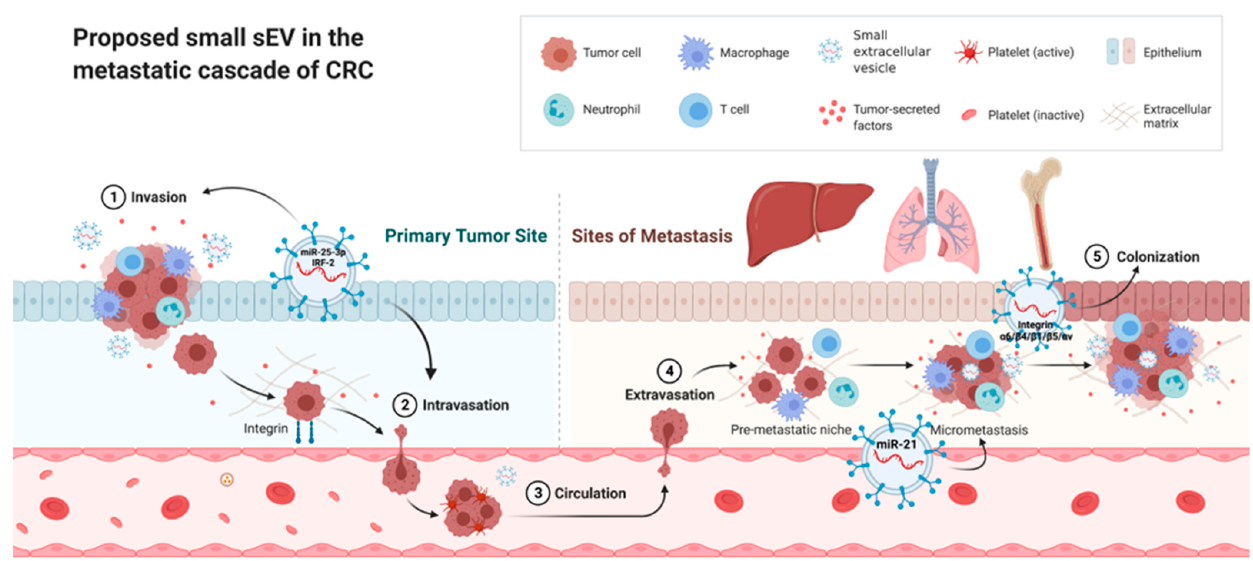
Figure 1. Proposed role of small EVs in the metastatic cascade of CRC Premetastatic niches (PMNs) possess six characteristics: vascular leakiness and angiogenesis, lymphangiogenesis, inflammation, immunosuppression, genetic reprogramming, and organotropism. sEVs play a vital role in each part of the above characteristics. CRC-derived sEVs containing miR-25-3p contribute to the induction of vascular leakiness and angiogenesis. Furthermore, sEVs containing miR-25-3p may impair the junctions of the endothelial cell layer. CRC-derived sEVs containing IRF-2 have been postulated to stimulate VEGF-C (vascular endothelial growth factor C) secretion, resulting in lymphangiogenesis and metastasis. sEVs containing miR-21 help polarize liver macrophages into an IL-6-secreting phenotype, contributing to the inflammatory environment. Tumor-derived sEVs express specific integrins to initiate the formation of PMNs in a particular tissue. Integrin α 6/integrin β 4/integrin β 1 and integrin β 5/integrin α v are enriched in sEVs with lung and liver tropism, respectively. (The figure was created at BioRender.com on 9 January 2022).